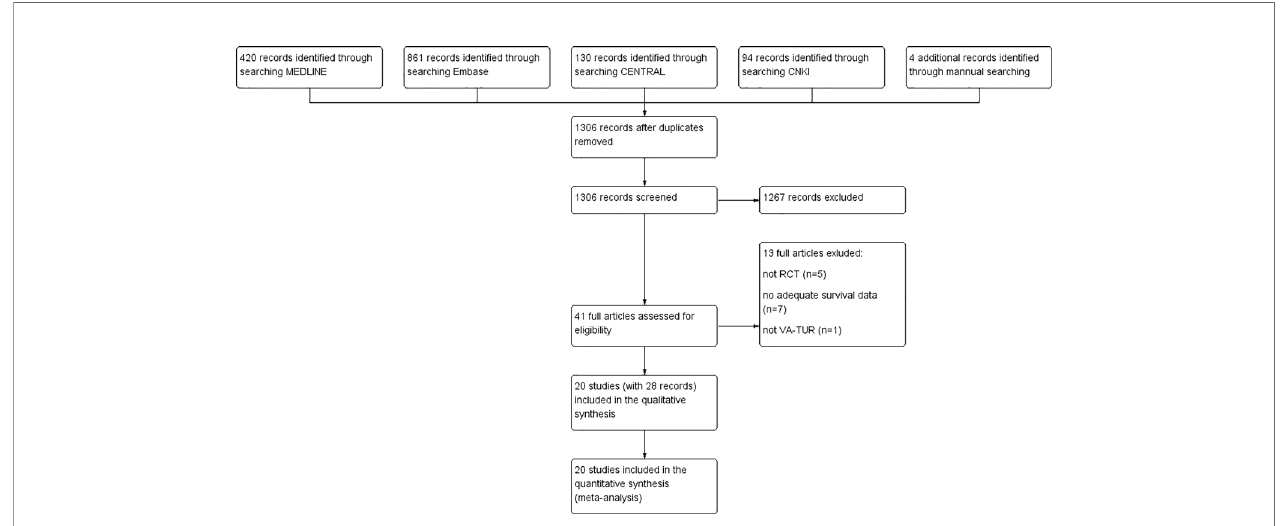
FIGURE 1 | Study fl ow